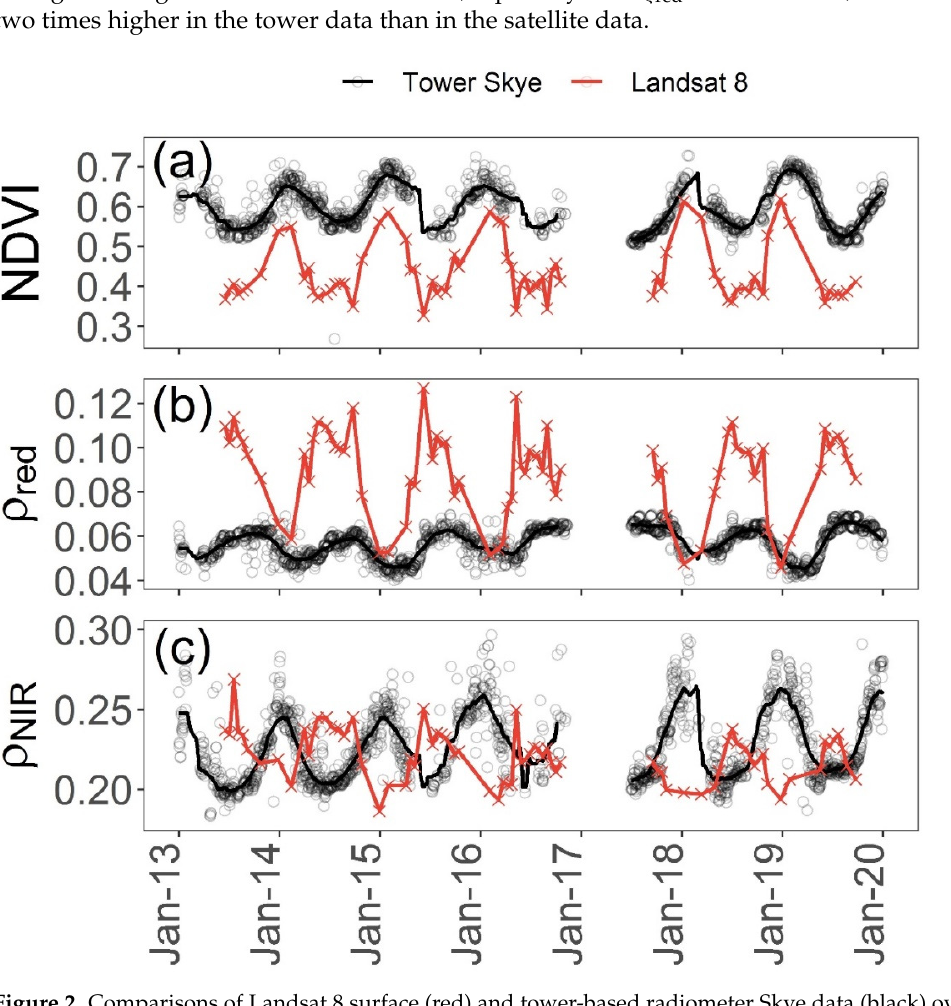
Figure 2. Comparisons of Landsat 8 surface (red) and tower-based radiometer Skye data (black) over a similar sensing area for the period of 2013–2019: ( a ) NDVI; ( b ) red reflectance; ( c ) NIR reflectance. Crosses indicate Landsat 8 data on a 16-day revisit cycle that were filtered for cloud cover below 10%. The open circles indicate daily Skye measurements that were averaged over 9:45–11:15 local time, and the black lines represent the 90-day moving average.